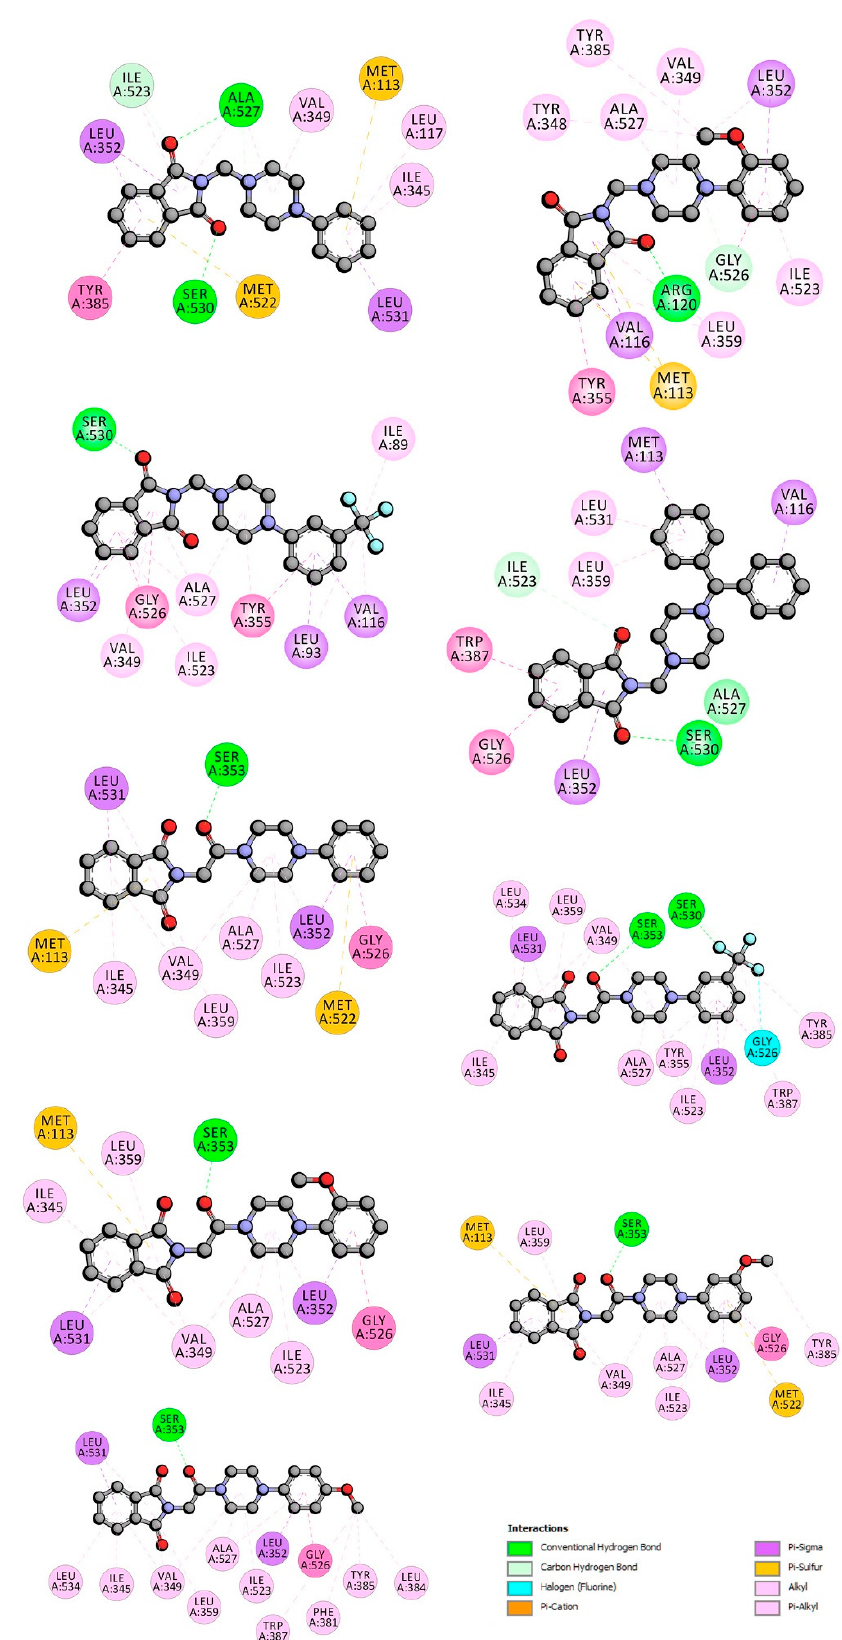
Figure 1. 2D interaction plot of studied compounds with COX-1.